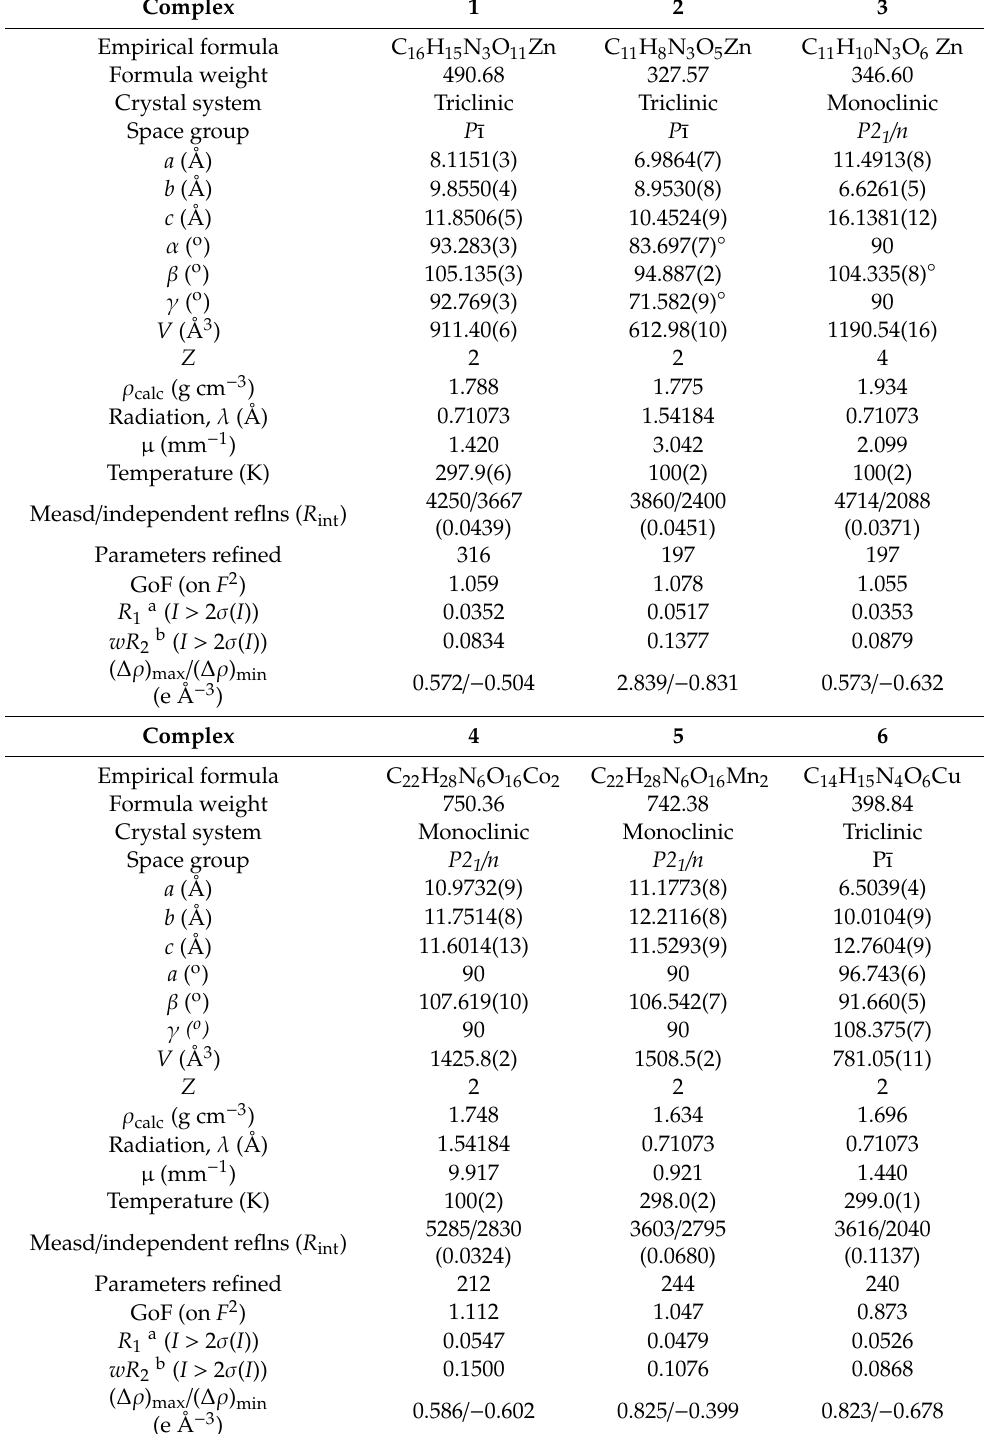
Table 1. Crystallographic data for complexes 1 – 9